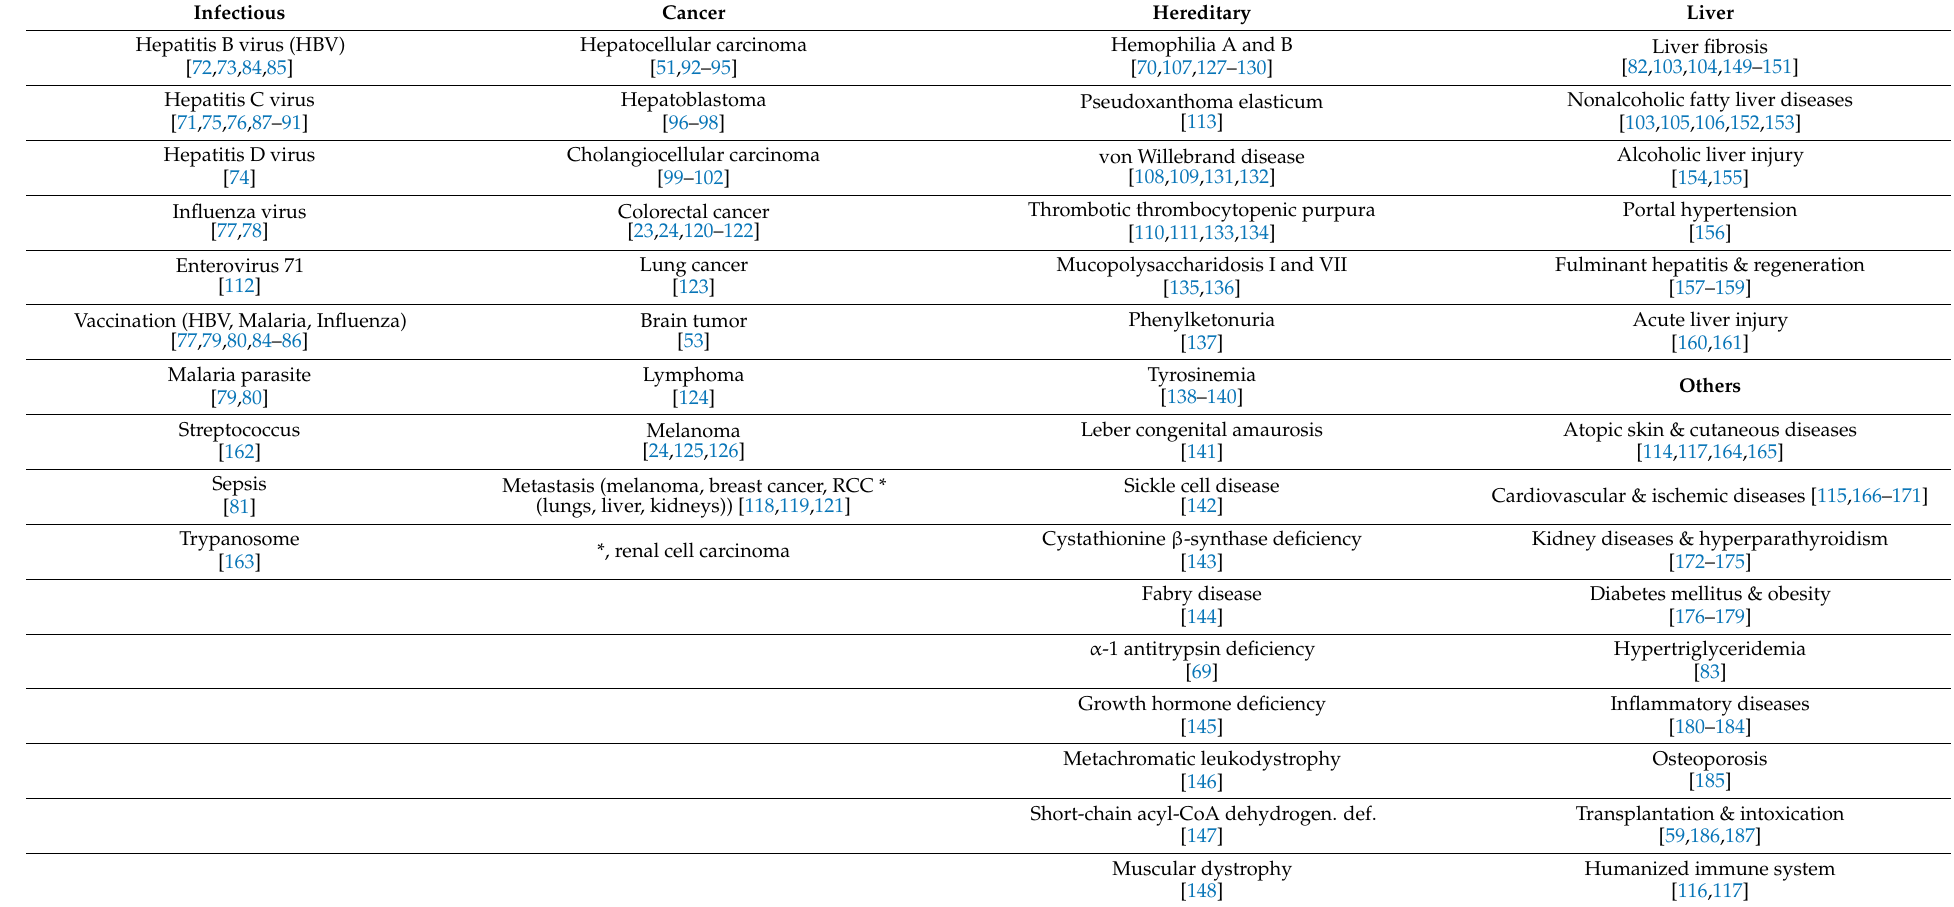
Table 2. Diseases for which hydrodynamic delivery has been utilized to explore the pathogenesis and/or therapeutic